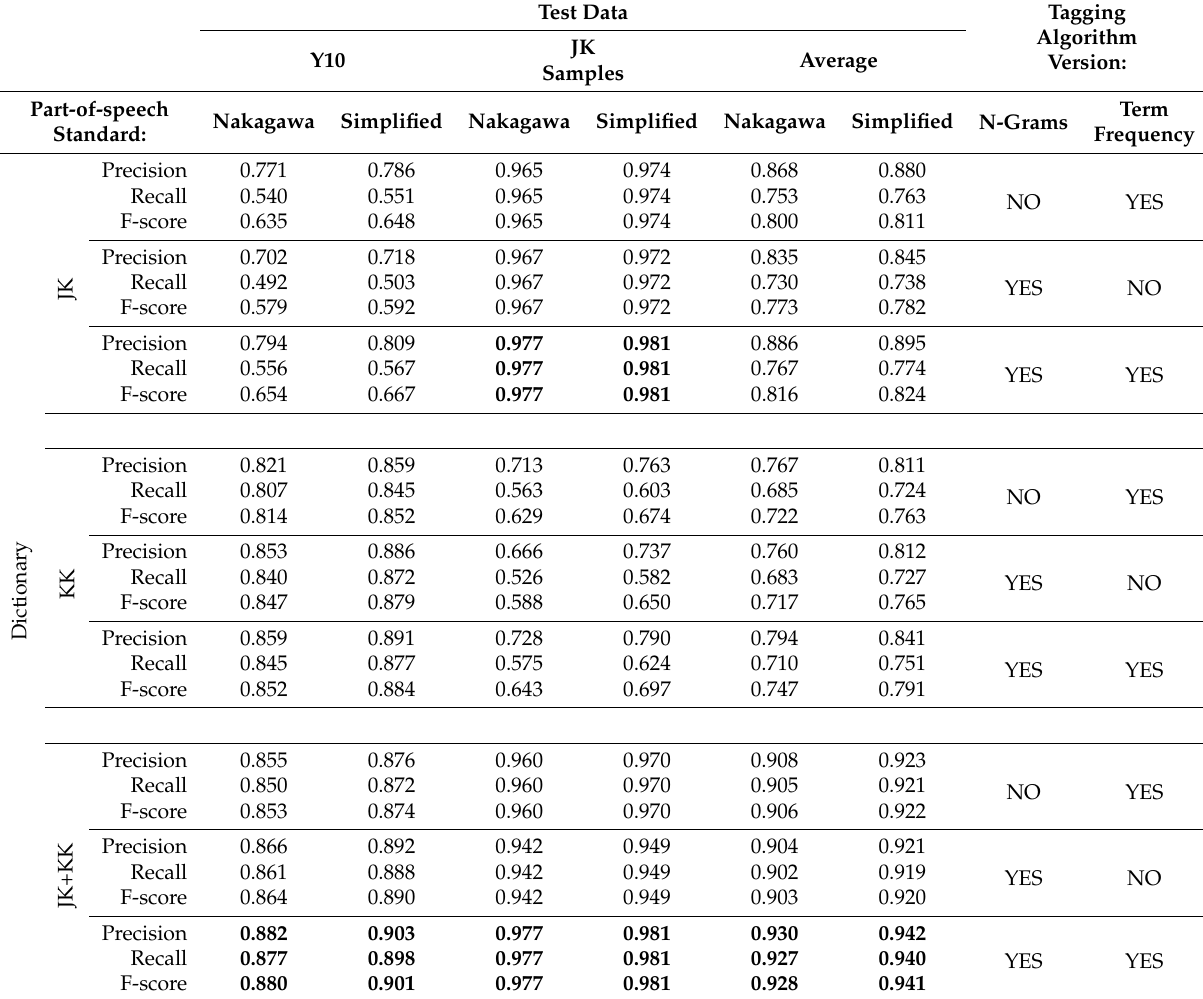
Table 14. Part-of-speech tagging experiment results (best results in